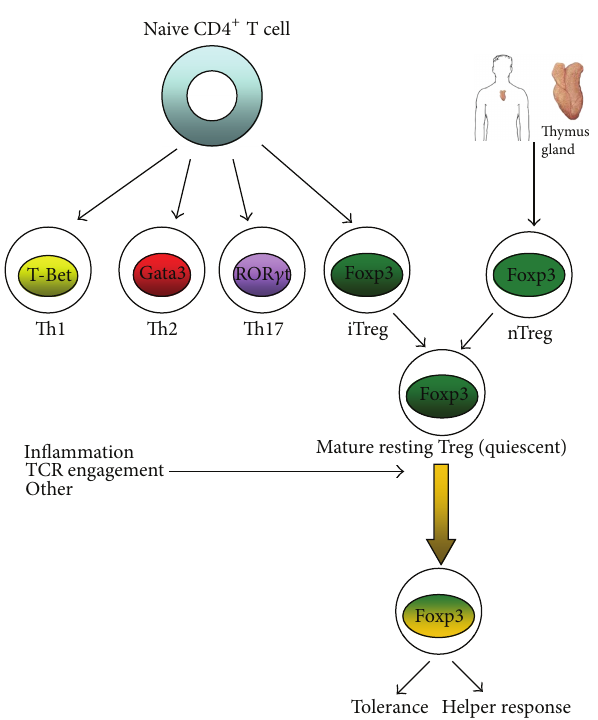
Figure 1: Origin and activation of Treg.